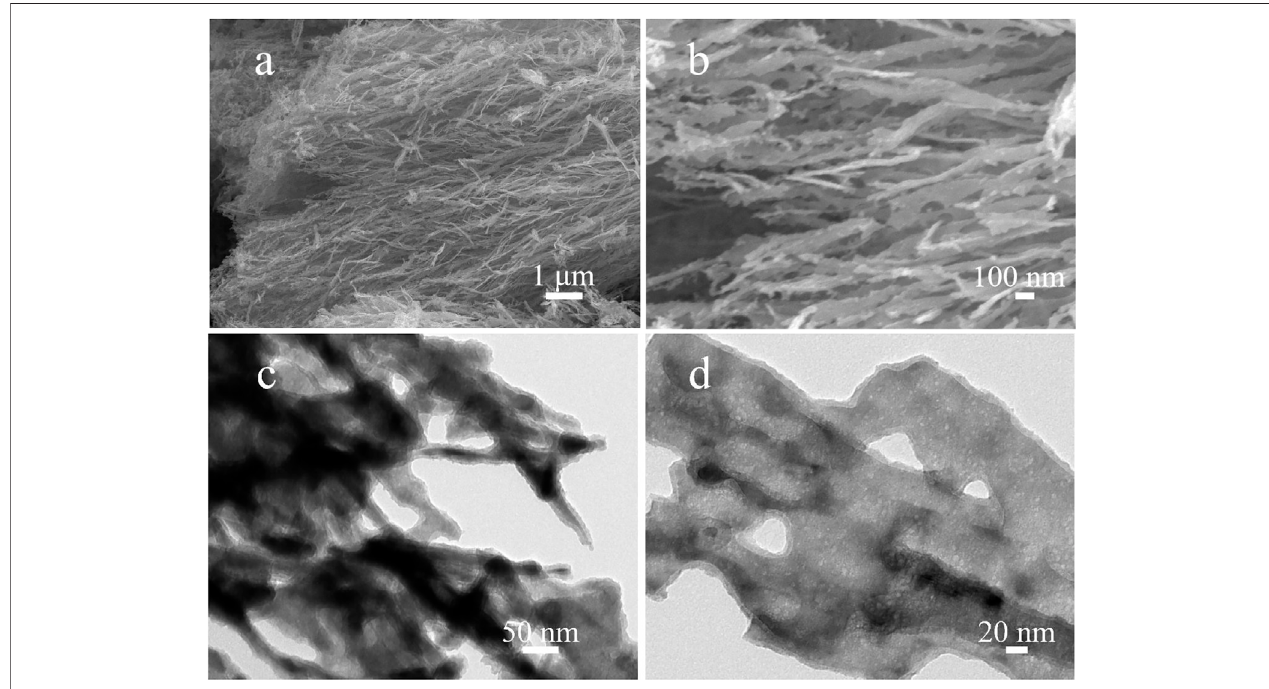
FIGURE 2 | (A, B) The SEM images of Ni 2 P nanowires; (C, D) The TEM images of Ni 2 P nanowires.